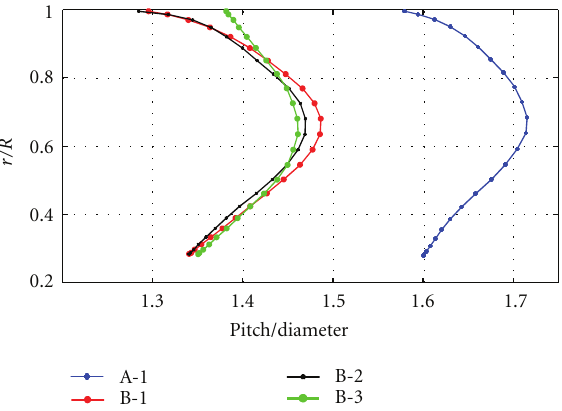
Figure 22: Pitch/diameter, aft propeller.